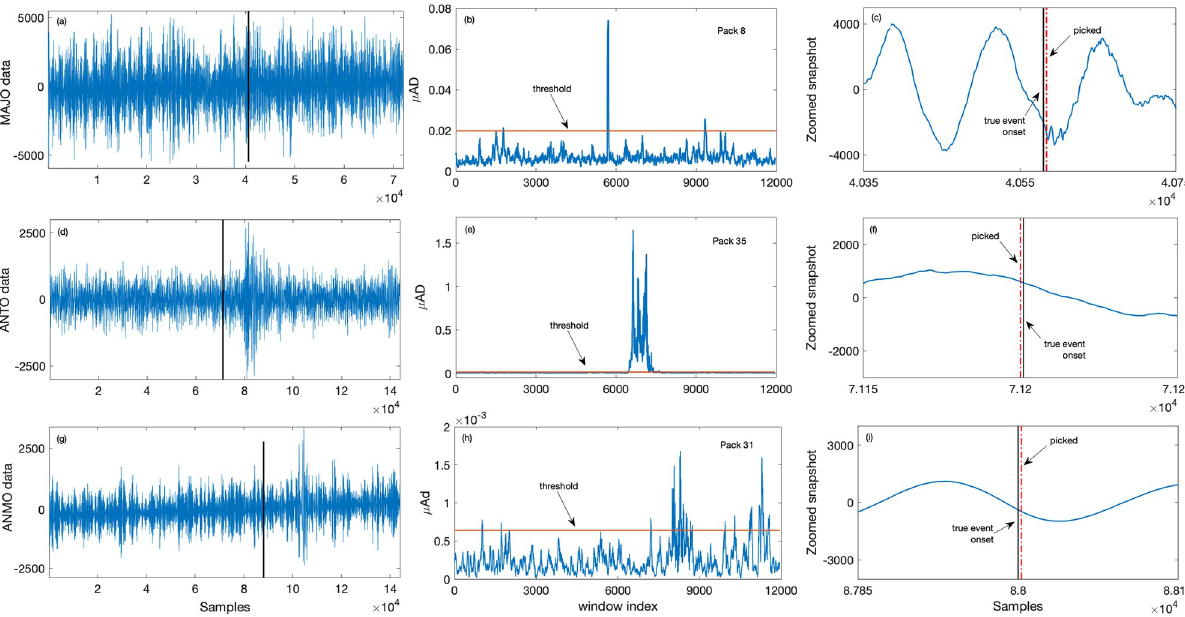
Fig 8. Event detection results for low SNR datasets. Plots (a), (d), (g) shows the vertical channel data from MAJO, ANTO, and ANMO station respectively, where the vertical black solid line indicates the onset of true event as reported on the IRIS website, plots (b), (e), (h) depicts corresponding μ AD in the selected packets. The solid horizontal line in the middle plots is the threshold value for the respective packets. Zoomed snapshots of respective data with picked events is shown in plots (c), (f) and (i) where the red vertical lines indicate the time at which the proposed method picks the event. Plots (c), (f), (i) shows the zoomed snapshot of data with picked events. https://doi.org/10.1371/journal.pone.0250008.g008 represents the detection error in samples, where a positive number indicates early detection and a negative number indicates delay. Numbers written in red color indicates the missed events. The corresponding SNRs are illustrated in the bottom plot of Fig 9. Furthermore, for ANMO station data, out of 42 events in Fig 9, the method fails to detect 4 events (bars with red